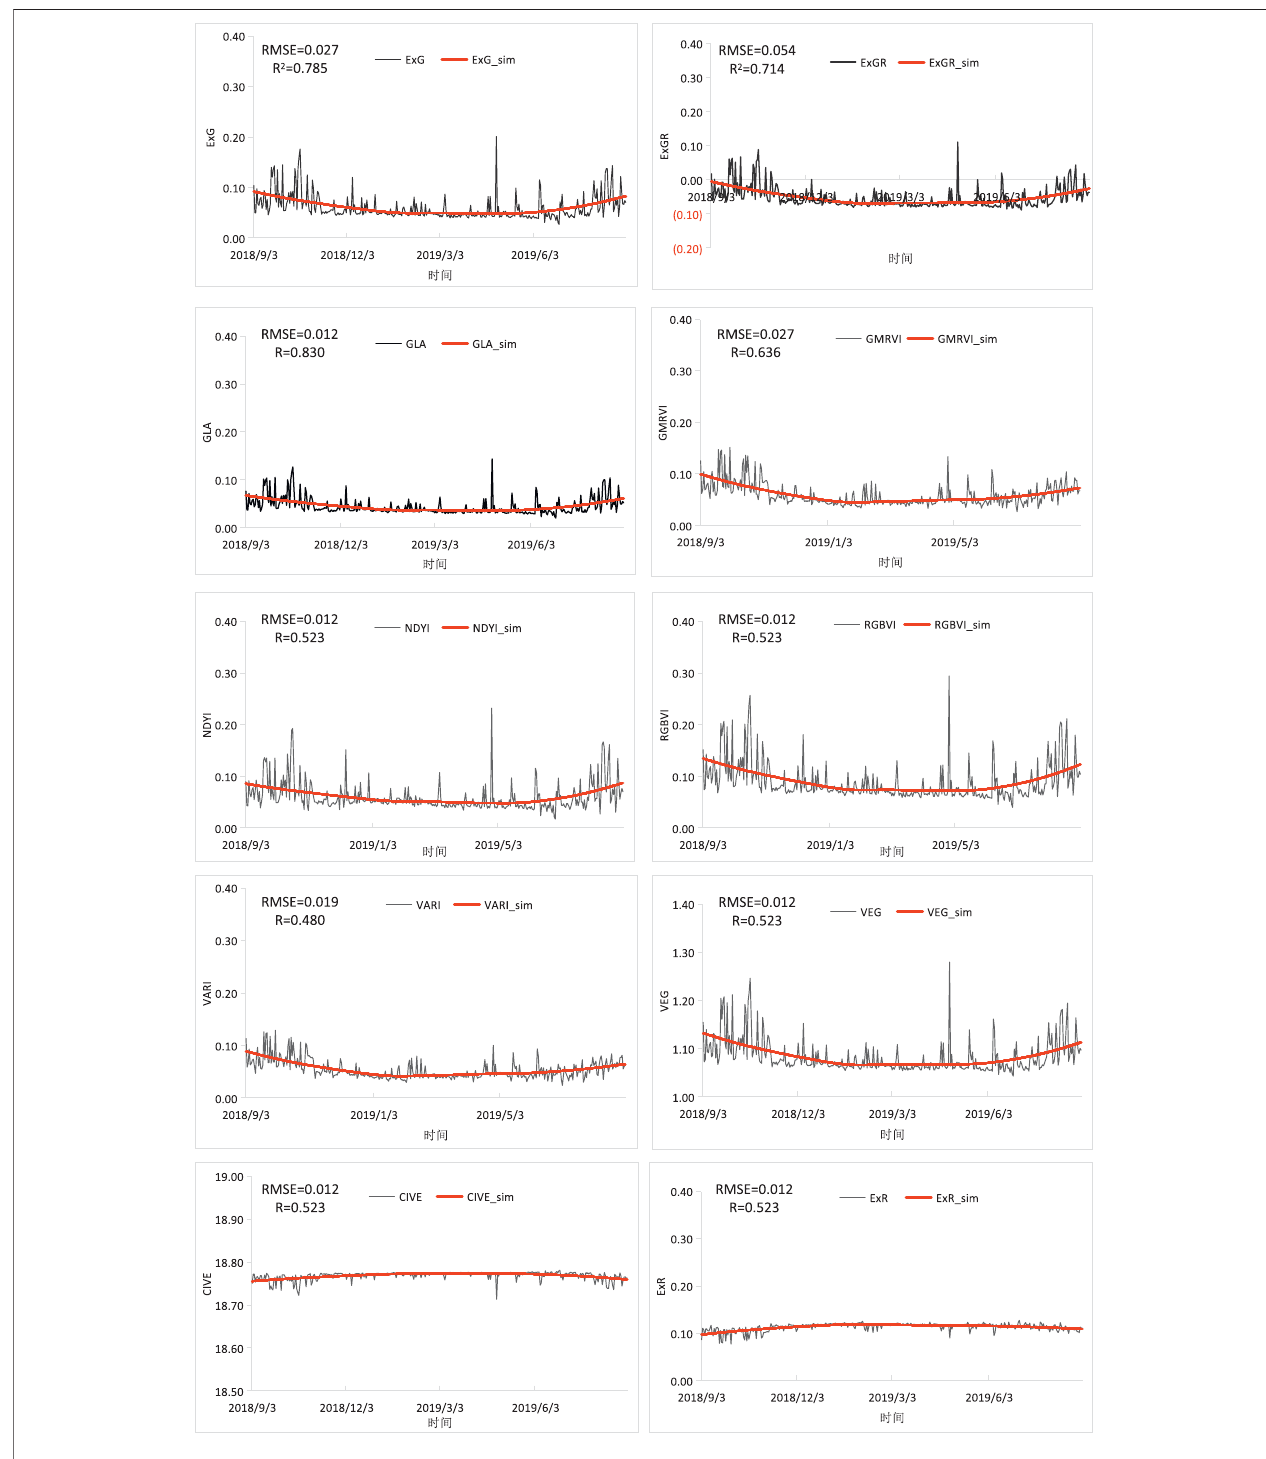
FIGURE 5 | Time variations of mangrove RGB vegetation